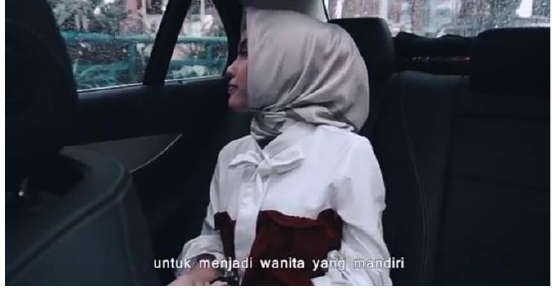
Figure 15: An Independent Muslim